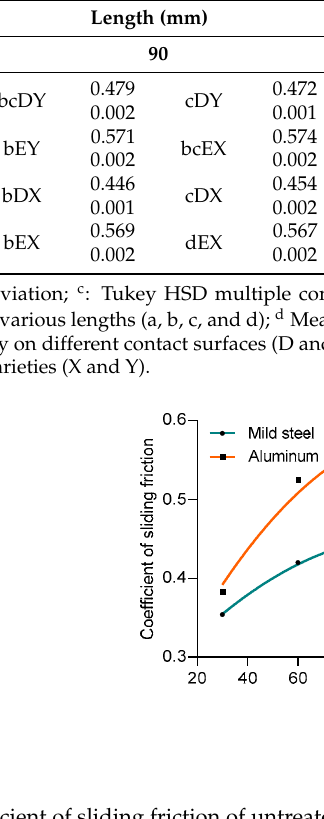
Figure 4. Effect of length on the coefficient of sliding friction of untreated wheat straw and rice straw at a moisture content of 75% (w.b) and normal pressure of 4 kPa (( a ): wheat straw; ( b ): rice straw). According to the results presented, previously, the coefficient of sliding friction of both test samples on the aluminum surface was markedly higher than on mild steel. The results of the means comparison showed that the difference was significant ( p < 0.01) in the length range from 30 to 150 mm for both varieties of samples. Furthermore, the coefficient of sliding friction of untreated wheat straw was greater than that of rice straw on both contact surfaces. A significant difference ( p < 0.01) was noted by referring to the comparison of means with only two